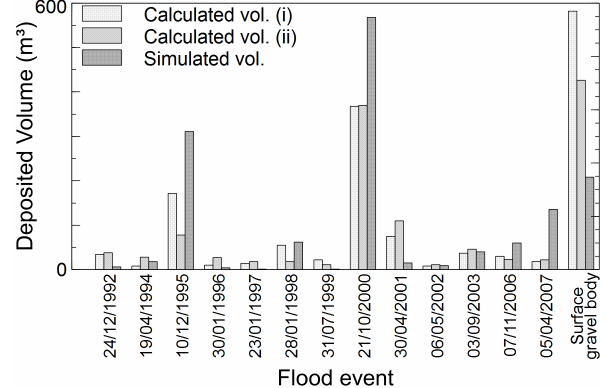
Fig. 11. Sediment temporal validation using the first calibration sed- iment parameter set: 13 events (out of 38 modelled flood events) were associated with the 15 detected flood units. The surface gravel body corresponds to the last three modelled events. The model was calibrated using the total sedimentation